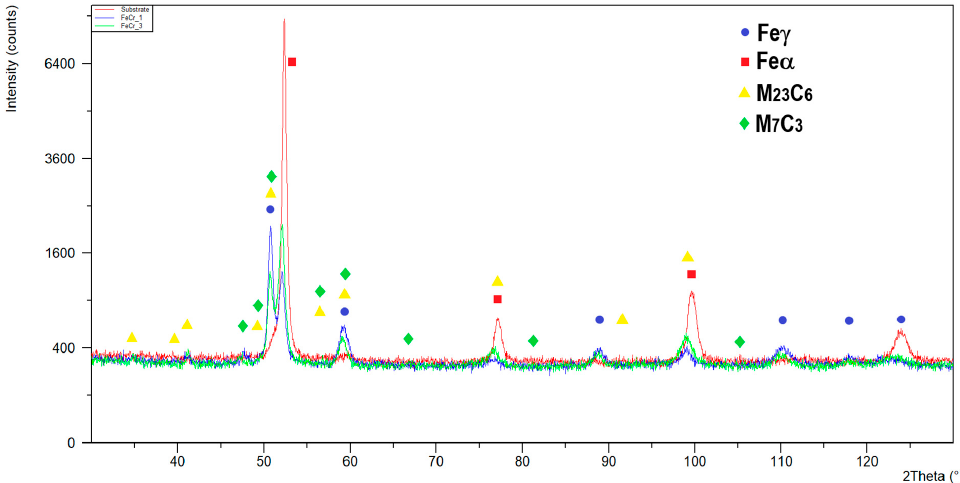
Figure 12. XRD patterns of the substrate of non-alloy steel S235JR and comparative coatings produced as multi-bead cladding at the processing parameters for LC4 and HC4 (scanning speed 250 mm/min, laser output power 1000 W, energy input 240 J/mm, free cooling and forced cooling respectively, Table 3). Metals 2020 , 10 , 190